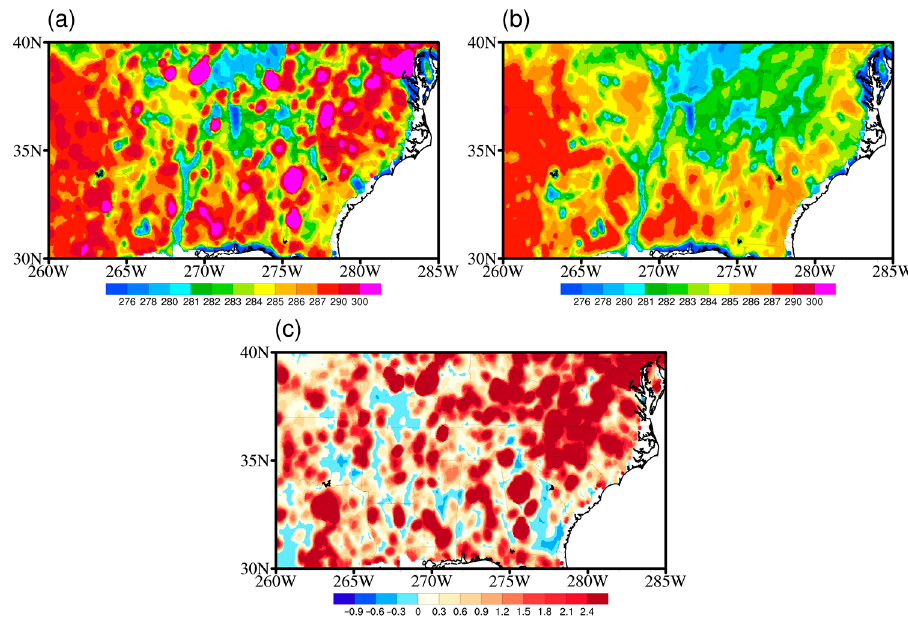
Figure 2. Spatial distributions of brightness temperatures of the 6.9-GHz-V channel ( a ) and the 10.7-GHz-V channel ( b ) over the U.S. continental area in the autumn of 2016; RFI signals identified by the NPCA for the 6.9-GHz-V channel are shown in ( c ).